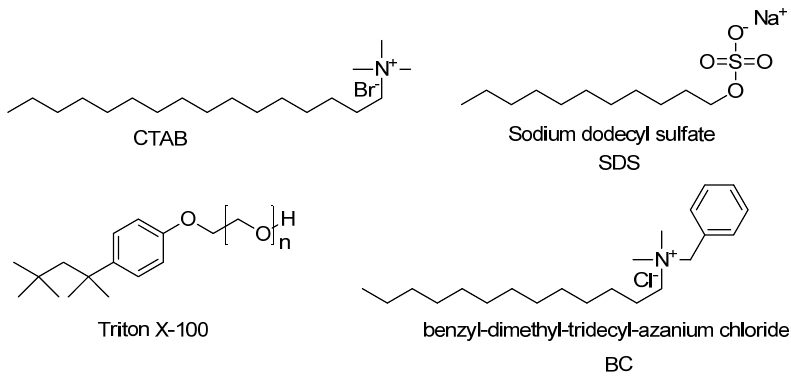
Figure 3. Surfactant-mediated responses of solutions containing 4- CTAB towards various thiols at pH 7.4. ( a ) Absorption spectra of 4 (2.5 μ M) upon addition of thiols (2 equiv)